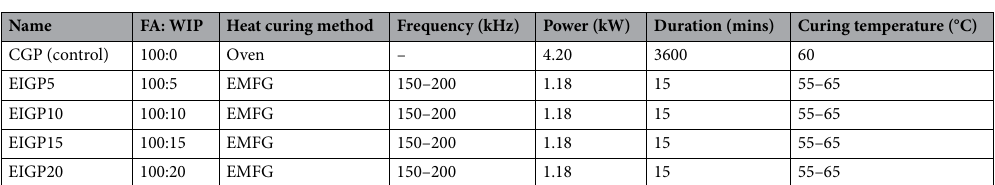
Table 3. Details of oven and EMF curing processes.